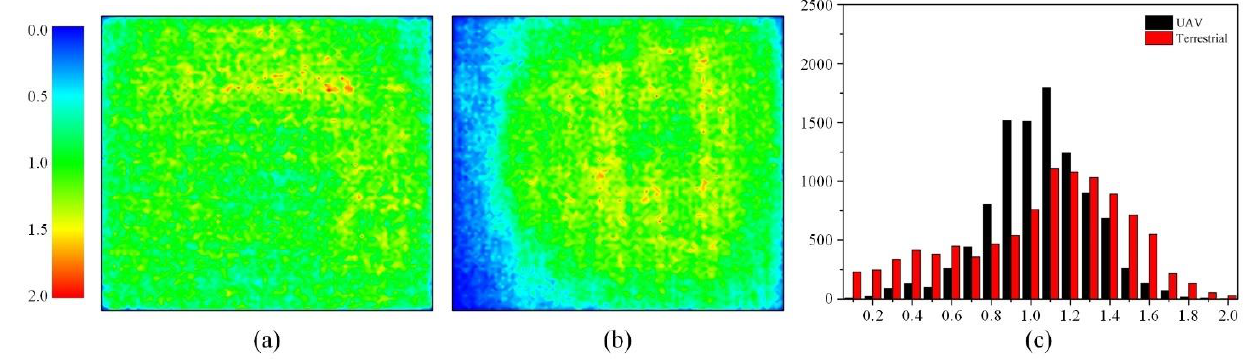
Figure 6. Tie point distributions for the Rathaus dataset: ( a ) aerial (UAV) and ( b ) terrestrial image spaces; ( c ) histograms.